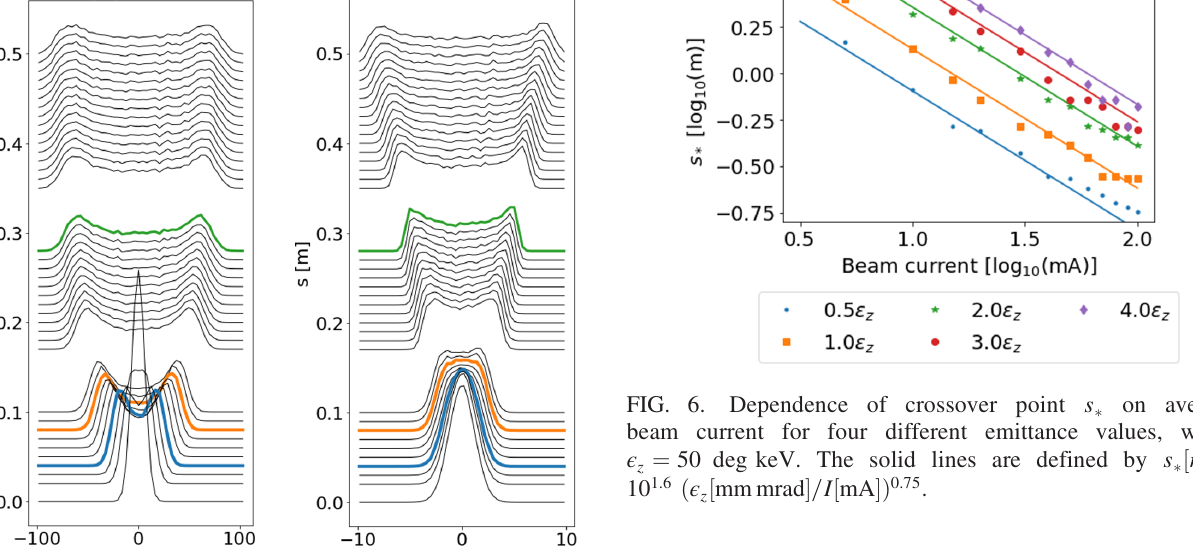
½ m (cid:2) (cid:3)